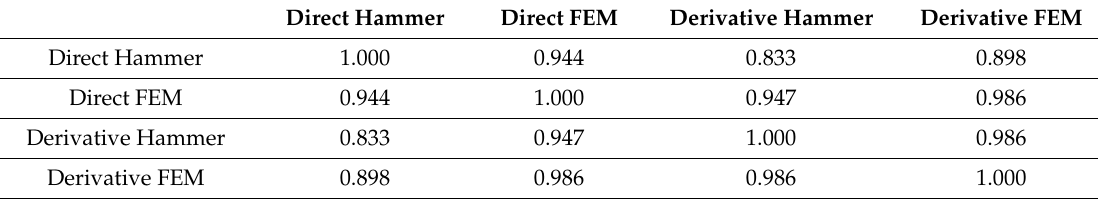
Table 8. MAC values for the second rotational mode for the UHPC2_L beam. Intact state.